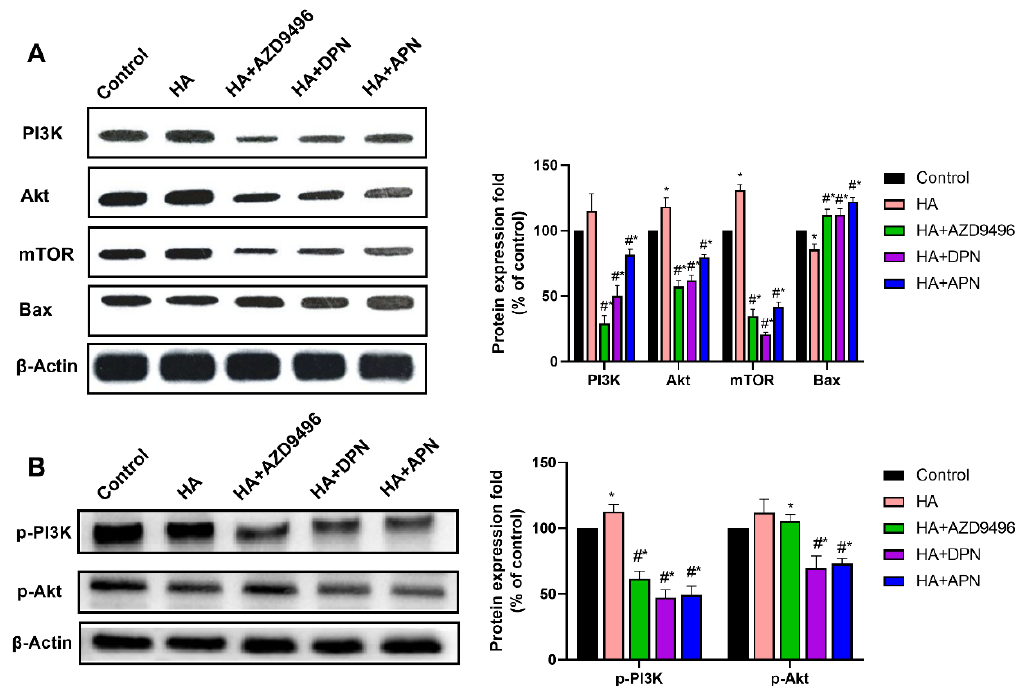
Figure 6. ( A ) Western blot analysis of PI3K, Akt, mTOR and Bax expression level from respective tumor tissues. The antibodies used in this experiment were PI3K (ABP52199), Akt (ABM40276), mTOR (ABP51866) and Bax (ABP55948). ( B ) Western blot analysis of p-PI3K and p-Akt expression levels from respective tumor tissues. The antibodies used in this experiment were p-PI3K(ab182651) and p-Akt(ab81283). The locus of p-PI3K and p-Akt was Y607 and S473 respectively. The results are expressed as a percentage of control, which is set at 100%. Data are presented as the mean ±